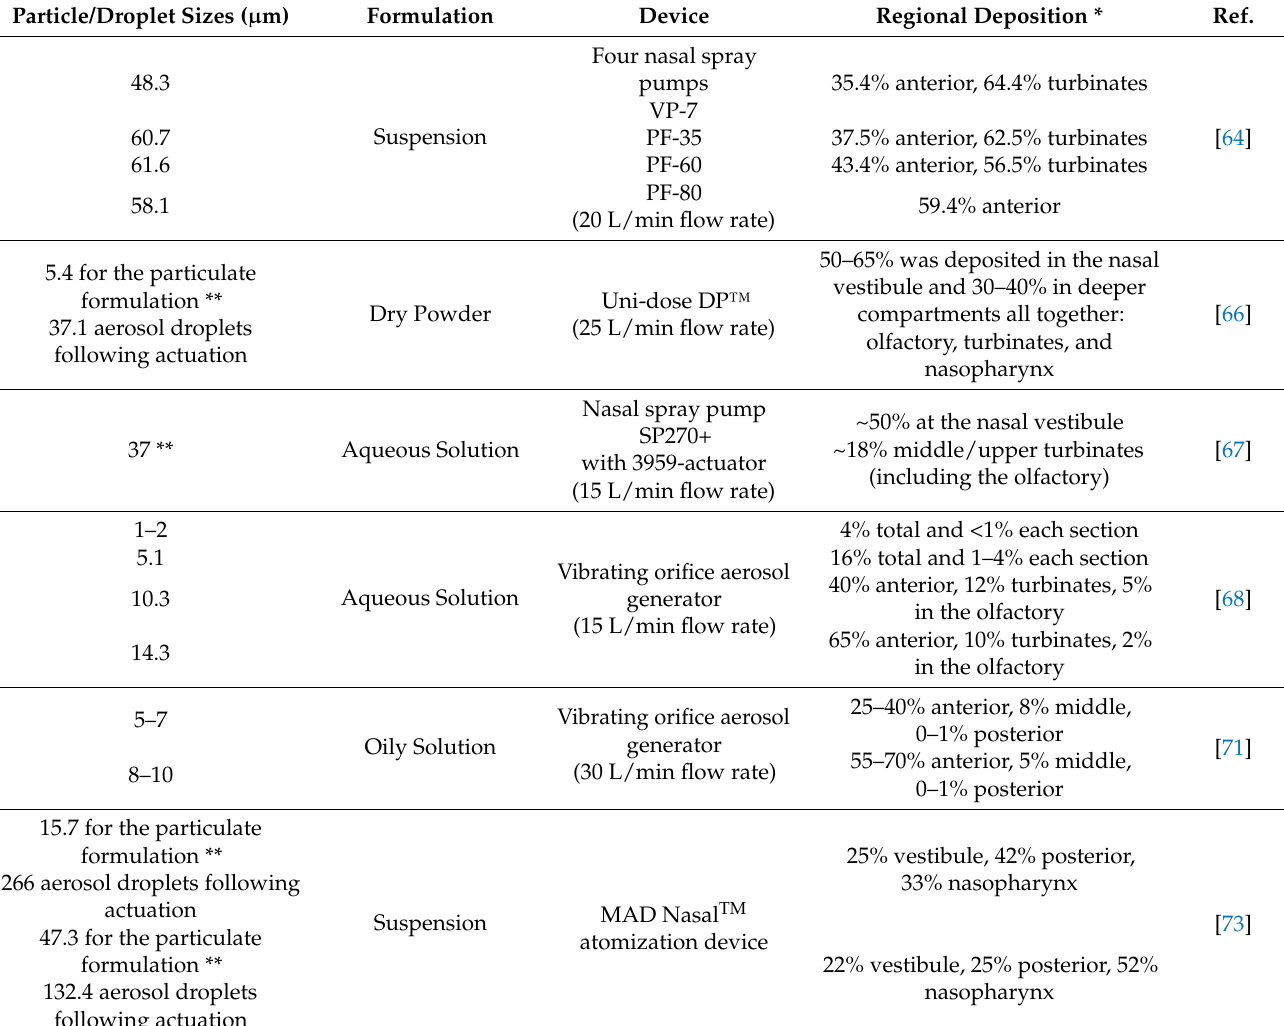
Table 2. Particle/droplet size distributions of nasal aerosol and the reported experimental regional